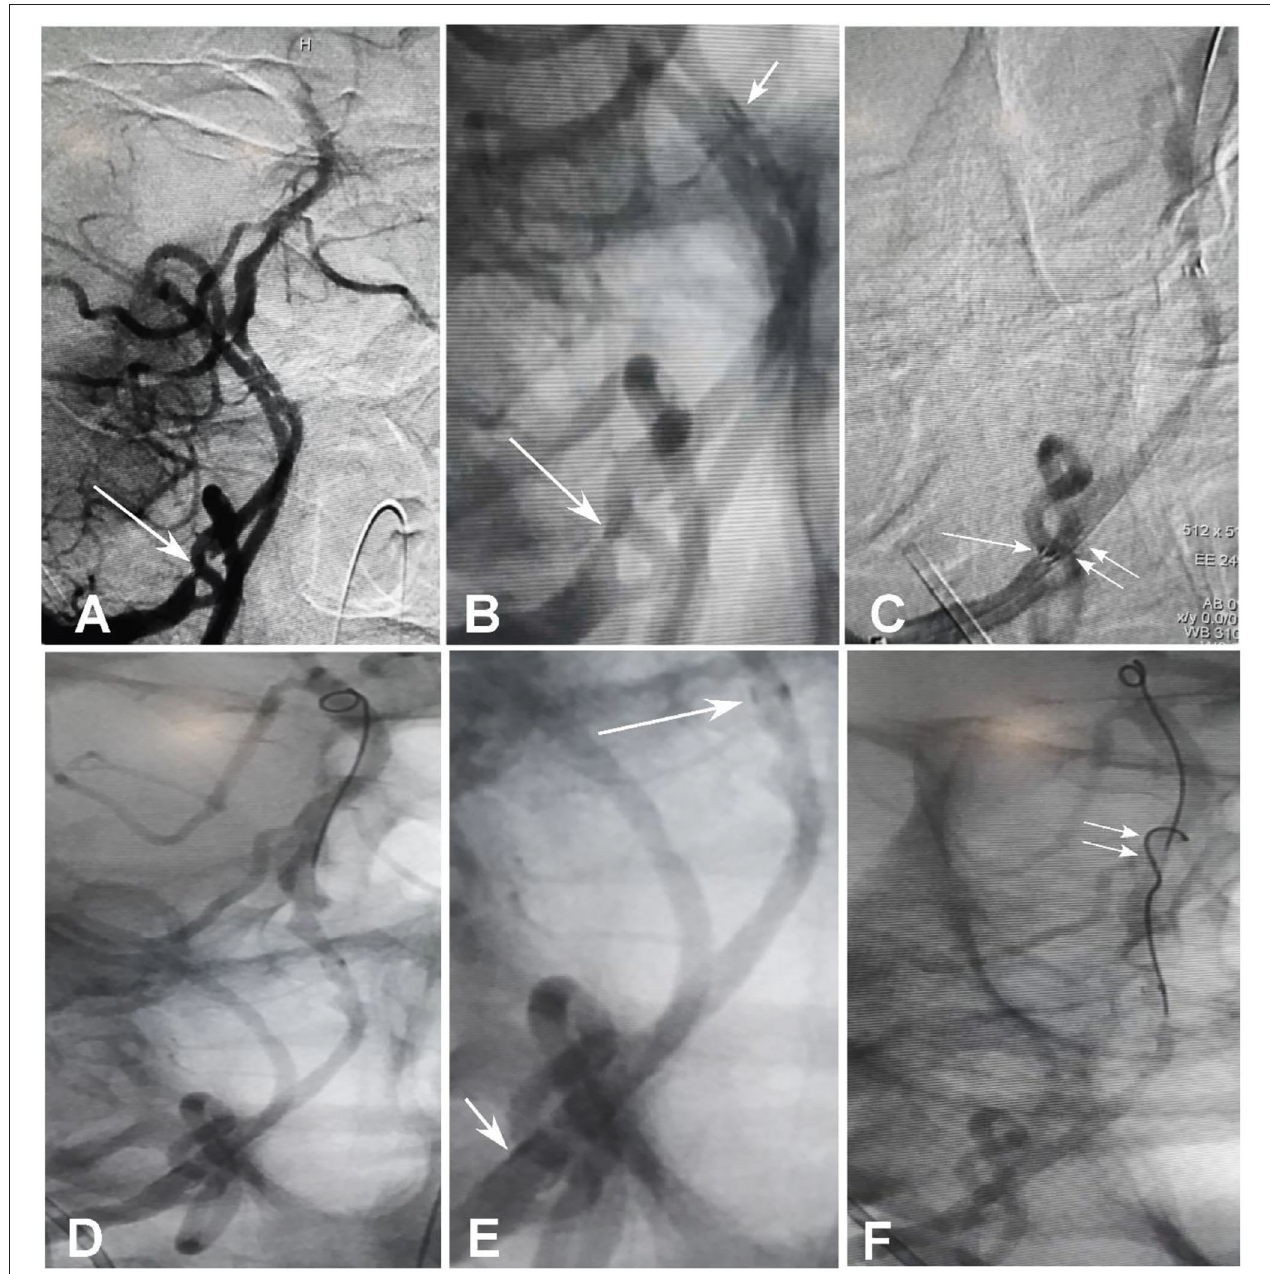
FIGURE 2 | Collapse of the stent proximal end and management. (A,B) Withdrawal of the micro-guidewire and microcatheter led to collapse of the stent proximal end with the stent proximal markers in close contact, and the blood flow was reduced through the proximal end. The longer arrow indicates the proximal markers and the shorter arrow the distal markers. (C) A 300-cm micro-guidewire was navigated into the stent lumen through the proximal lateral stent mesh rather than through the proximal stent end. The longer arrow indicates the collapsed proximal markers of the stent, whereas the double arrows indicate the micro-guidewire through the stent lateral mesh. (D,E) After the micro-guidewire was sent to the distal segment of the basilar artery, the proximal stent end was opened with the proximal markers being spread out [ (E) , shorter arrow]. The longer arrow indicates the distal stent markers. (E) is the local enlargement of (D) between the proximal and distal markers of stent. (F) A second 200-cm micro-guidewire was sent right through the opened proximal stent end into the stent lumen (double arrows).